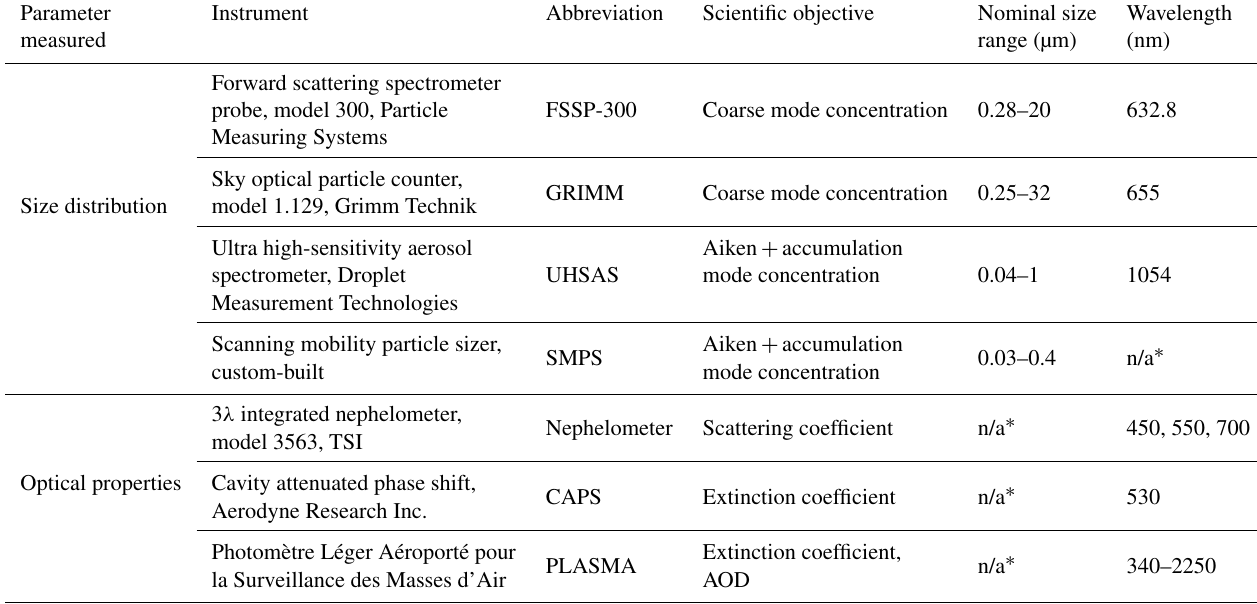
Table 1. Instruments on board the ATR-42 aircraft during F30 and F31